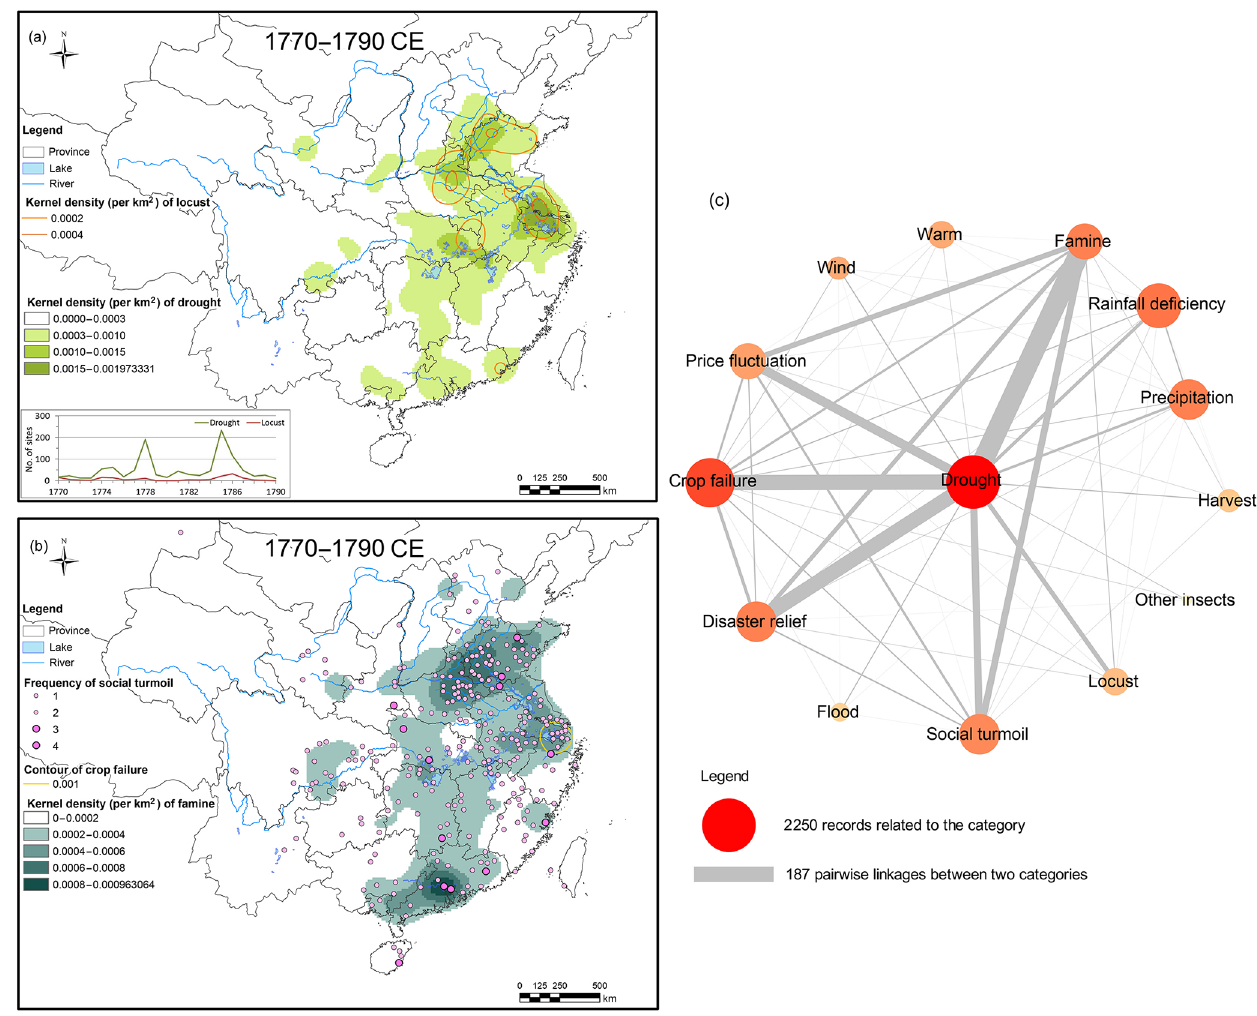
Figure 9. Spatial distribution of the kernel density function of drought and locust outbreaks (a) and social turmoil (b) , and the social network chart (c) in the drought period